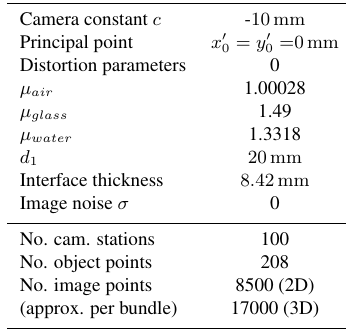
Table 1. Setup parameters for both evaluated data sets. d 1 is the distance from the perspective center to the first interface.